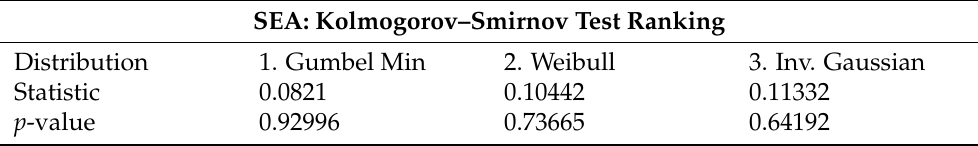
Table 10. Kolmogorov–Smirnov test values for the three best fitted two-parameter distributions for the sea